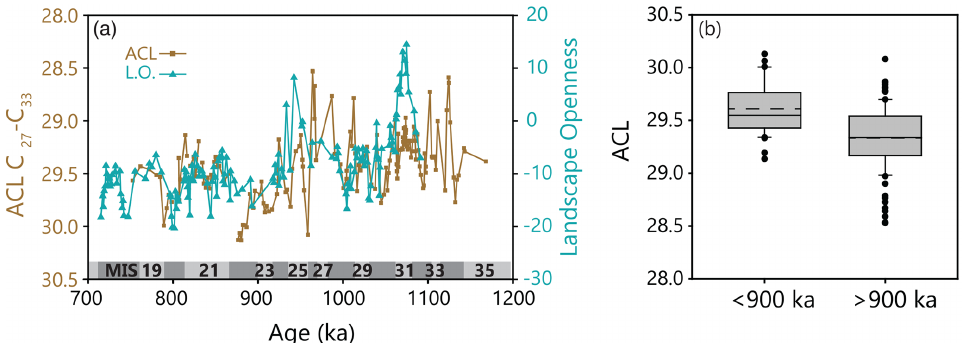
Figure 2. Comparison of Lake El’gygytgyn n -alkane and pollen data. (a) The ACL of the C 27 –C 33 n -alkanes plotted along with the landscape openness (L.O.) index derived from pollen spectra (data from Zhao et al., 2018). (b) Boxplots of the ACL data for all samples younger than 900ka and all samples older than 900ka. The solid line represents the median value and the dashed line the mean. Individual outliers are plotted.